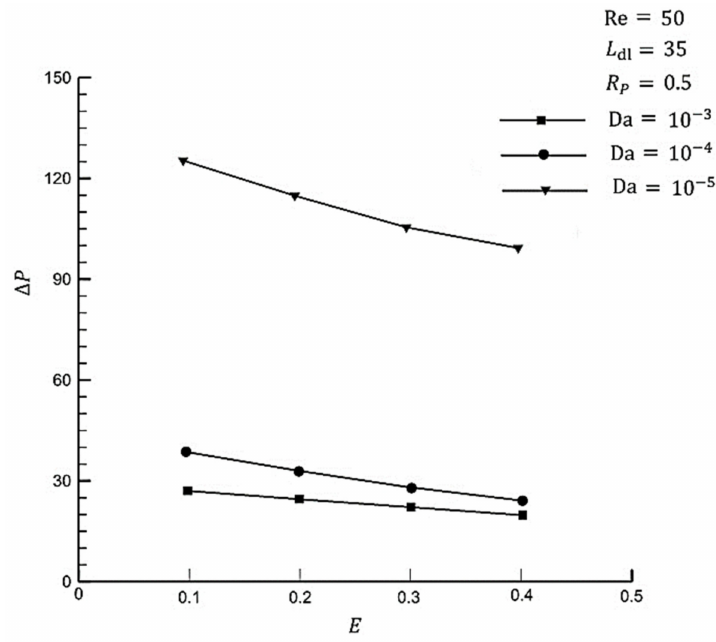
Figure 18. Effect of porous medium eccentricity on pressure drop.